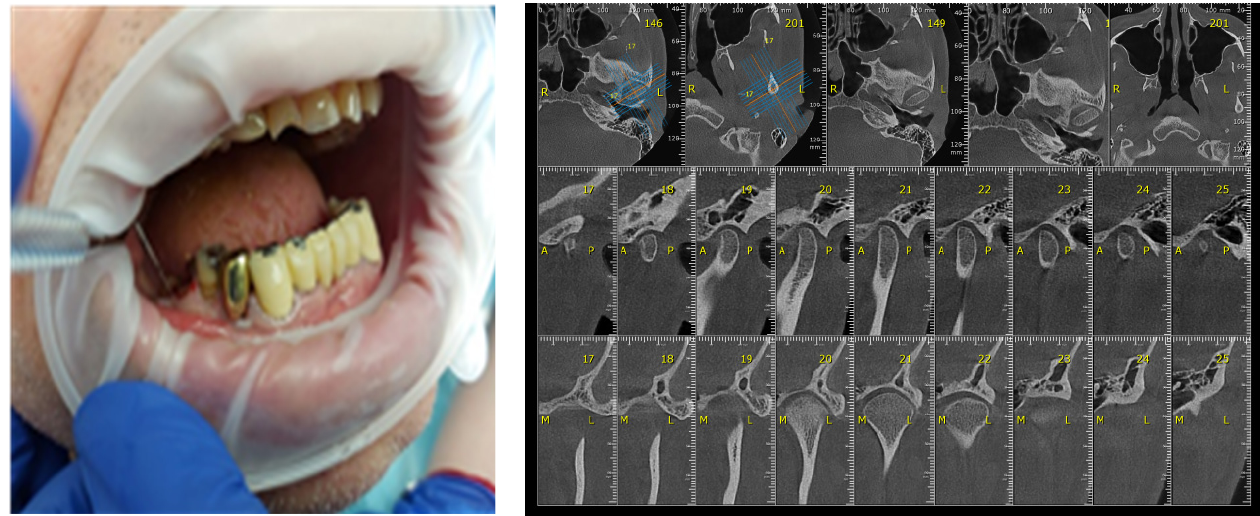
Figure 6. Correlation between Periodontal probing and TMJ exam. ( a ) Clinical aspects of periodontal damage; ( b ) TMJ changes related to periodontal status.